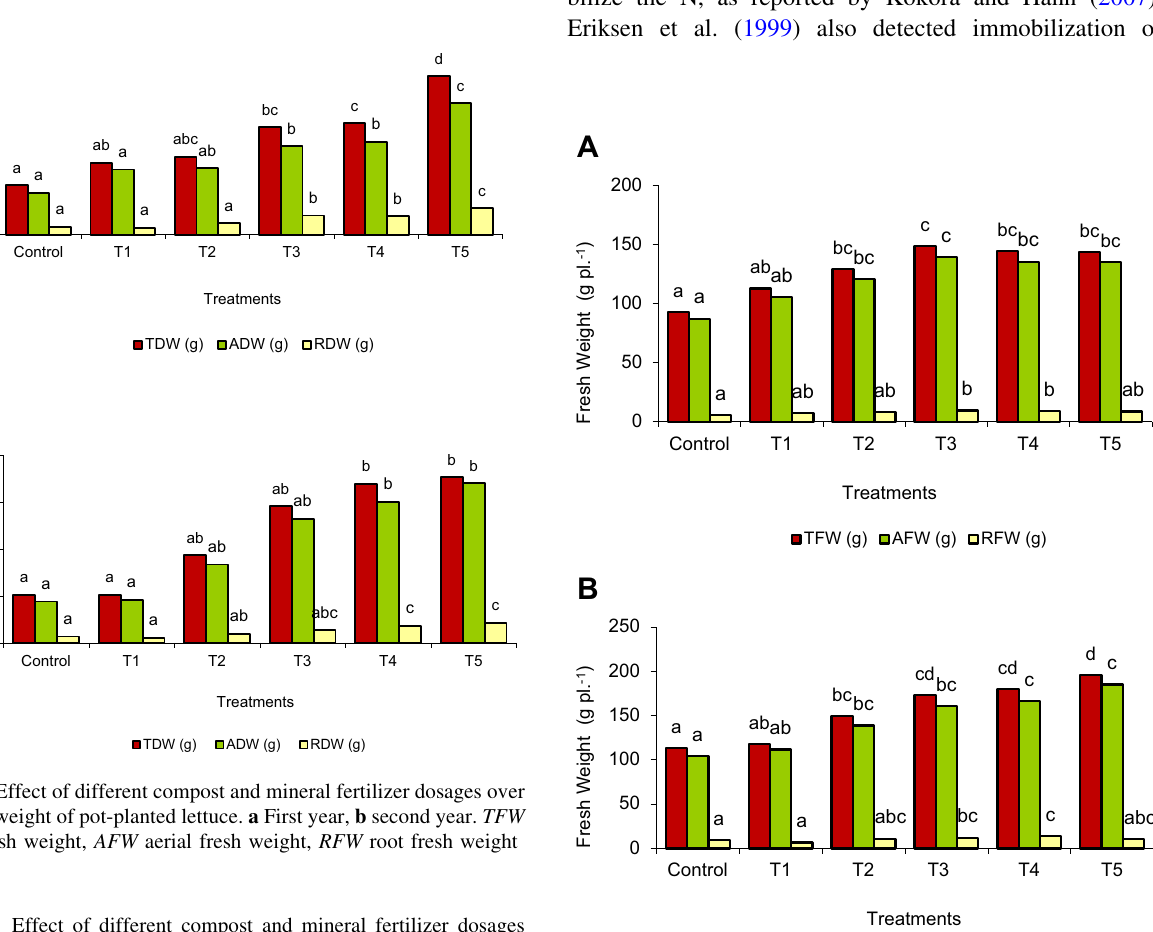
Table 2 Effect of different compost and mineral fertilizer dosages over lettuce cultivation yield (Mg ha - 1 ) Year Control T1 T2 T3 T4 T5